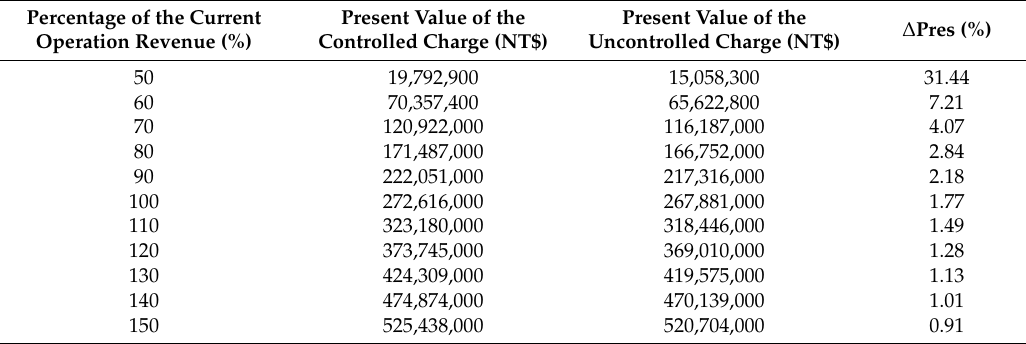
Table 7. Detailed sensitivity results of the operation revenue parameter.